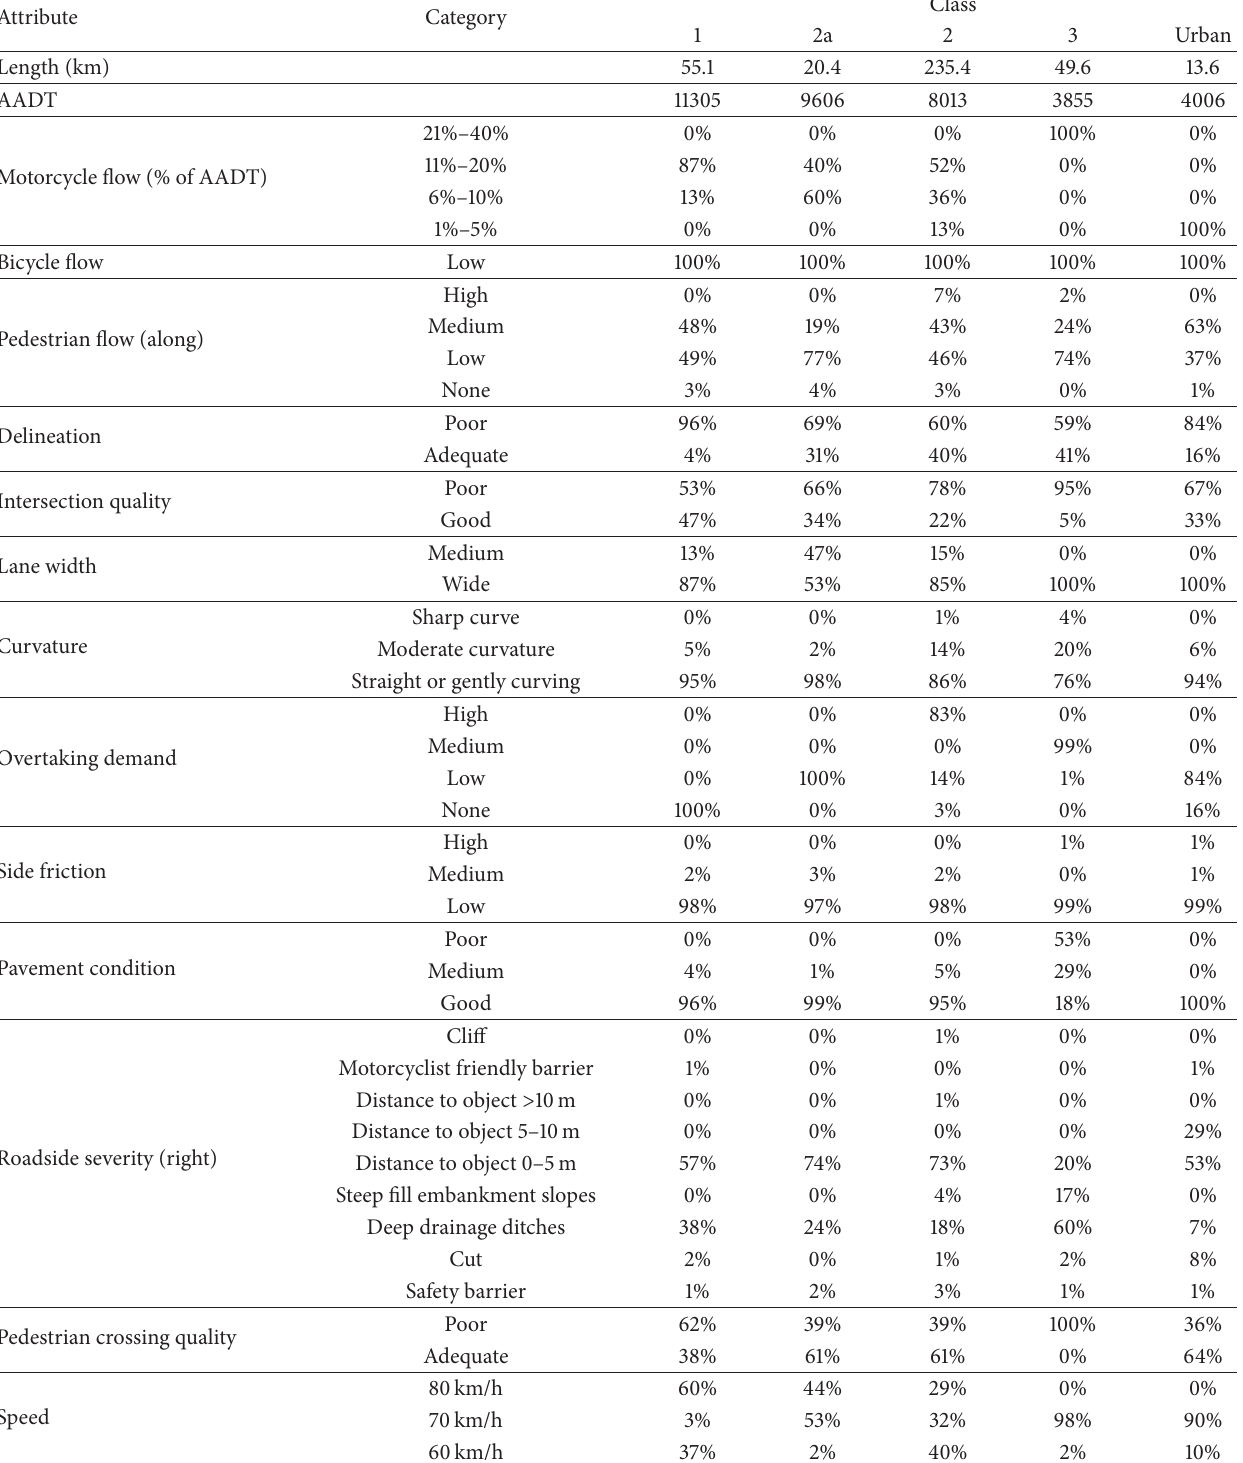
Table 4: Key data and road